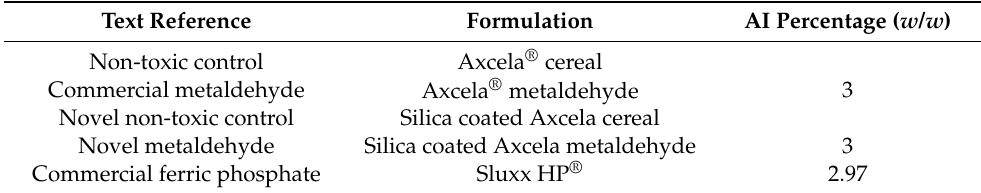
Table 1. Text reference, formulation name and active ingredient (AI) percentage ( w / w ) for pellets used in laboratory and area